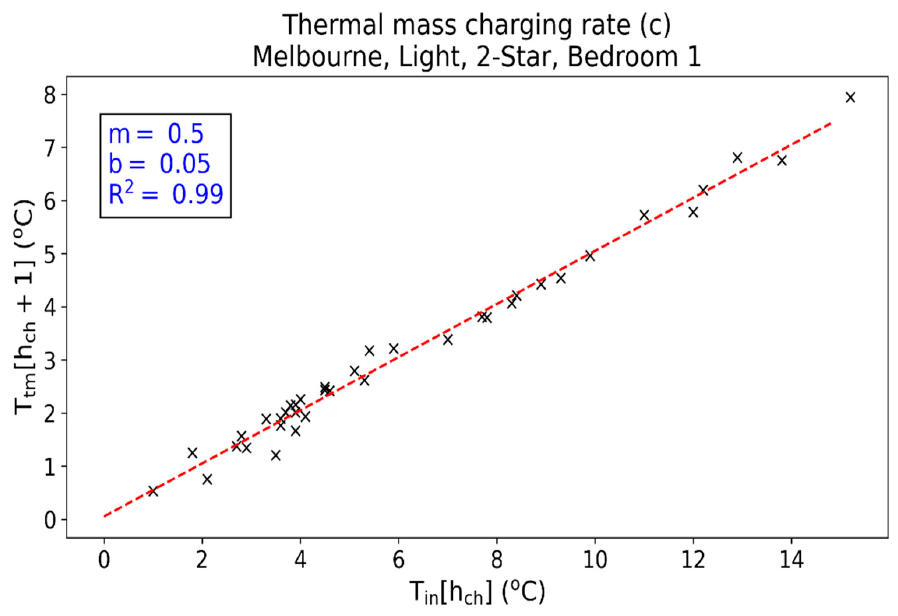
Figure 3. Scatter plot of T in [ h ch ] versus T tm [ h ch + 1], defining the thermal mass charging rate ( c ) for Bedroom 1 in template home M2L.